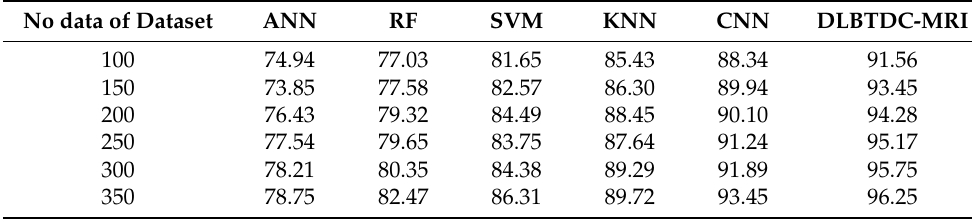
Table 3. F-Score analysis of DLBTDC-MRI method with existing system.